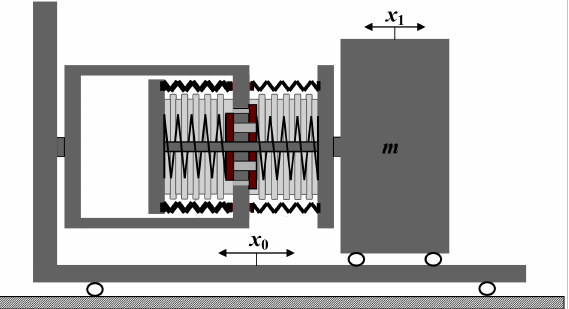
Figure 5. PWL system for mitigation the dynamic forces transmitted from the base input to the sprung